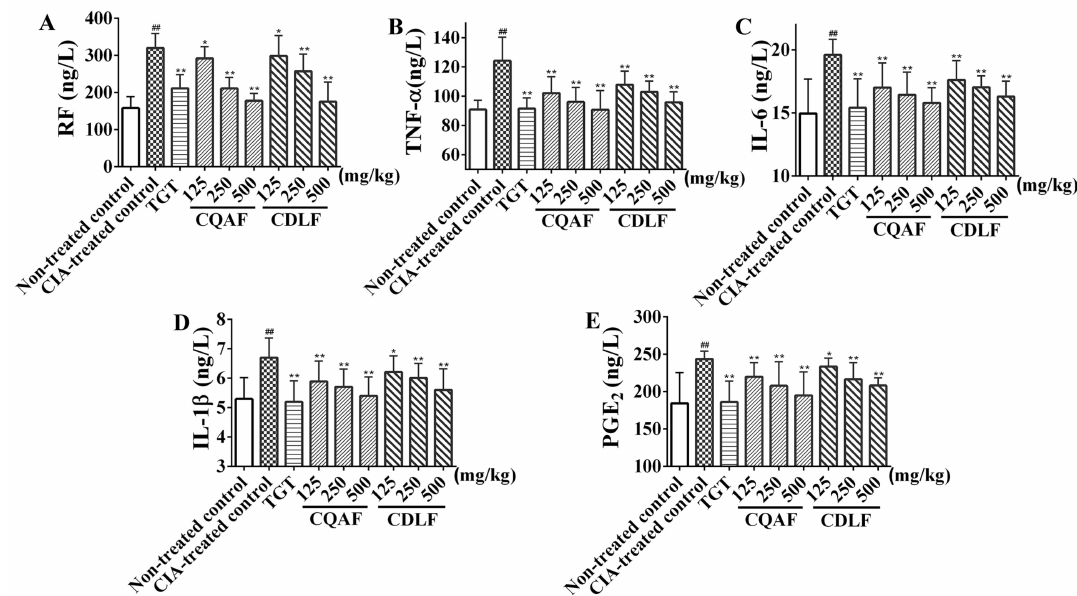
Figure 4. Effects of CDLF and CQAF on serum RF, TNF- α , IL-6, IL-1 β , and PGE 2 in the CIA rats. ( A ) RF; ( B ) TNF- α ; ( C ) IL-6; ( D ) IL-1 β ; ( E ) PGE 2 . The data are presented as the mean ± SD ( n =